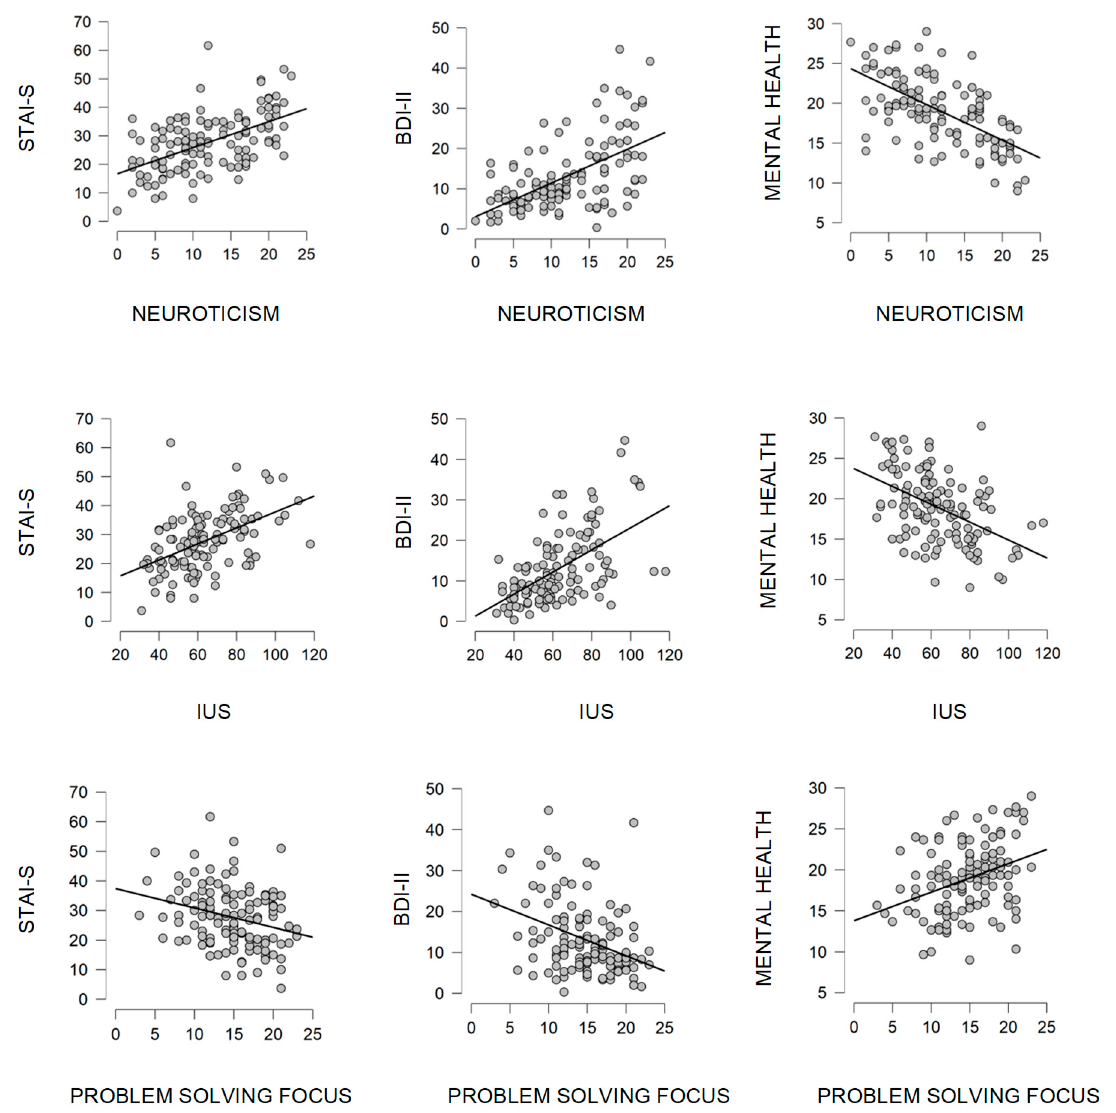
Figure 2. Dispersion graphs showing the two patterns of associations (IUS = Intolerance of Uncertainty).